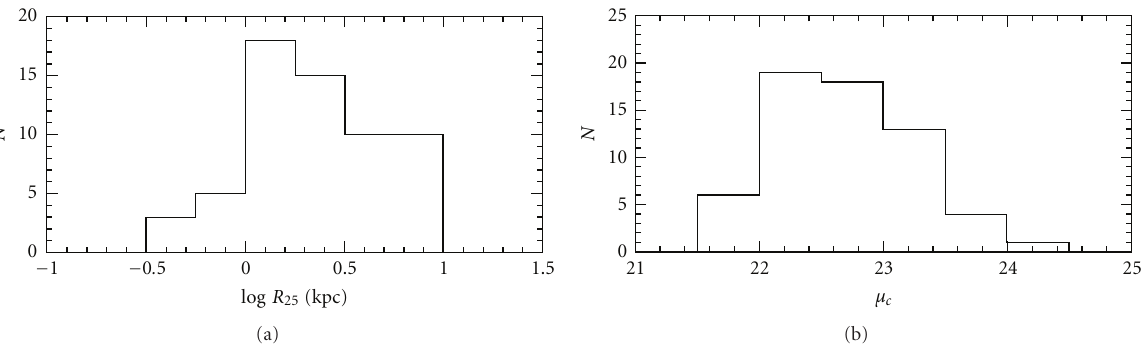
Figure 4: The range of size and central surface brightness (Vmagarcsec − 2 ) for the sample. As demonstrated in early work, not all LSB galaxies are dwarf galaxies in terms of size (although the LSB giants, e.g., F568-6, were excluded from the sample due to the restrictions on redshift range).